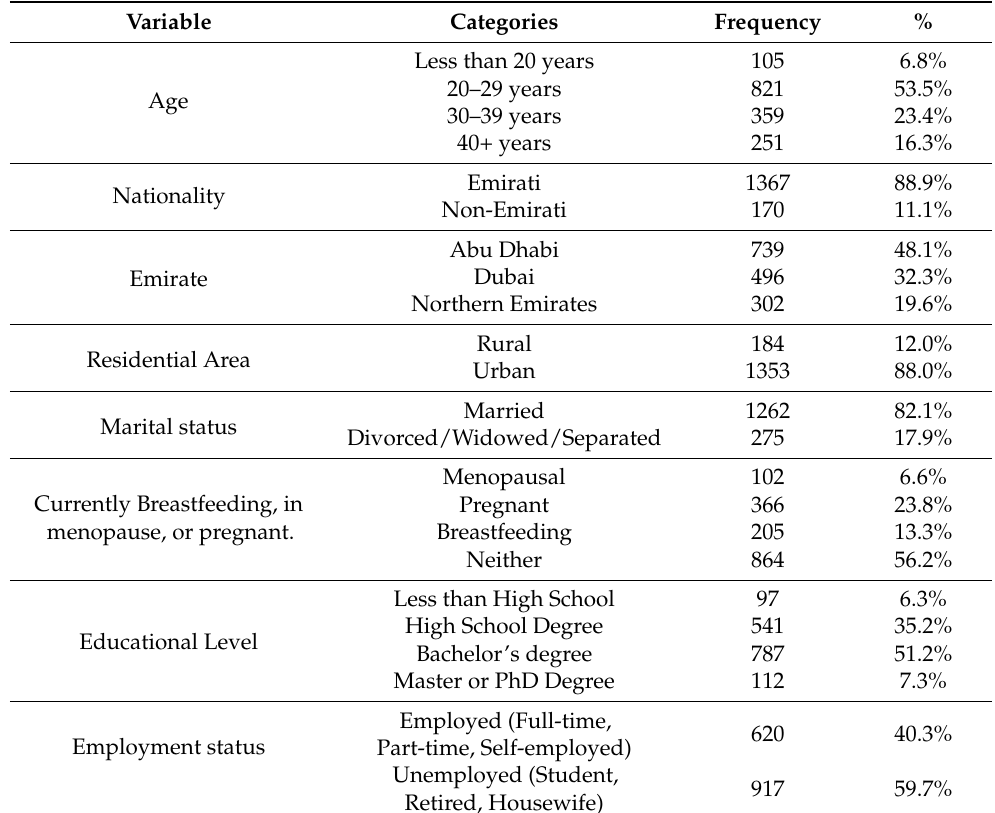
Table 1. Sociodemographic characteristics of the respondents ( n = 1537).